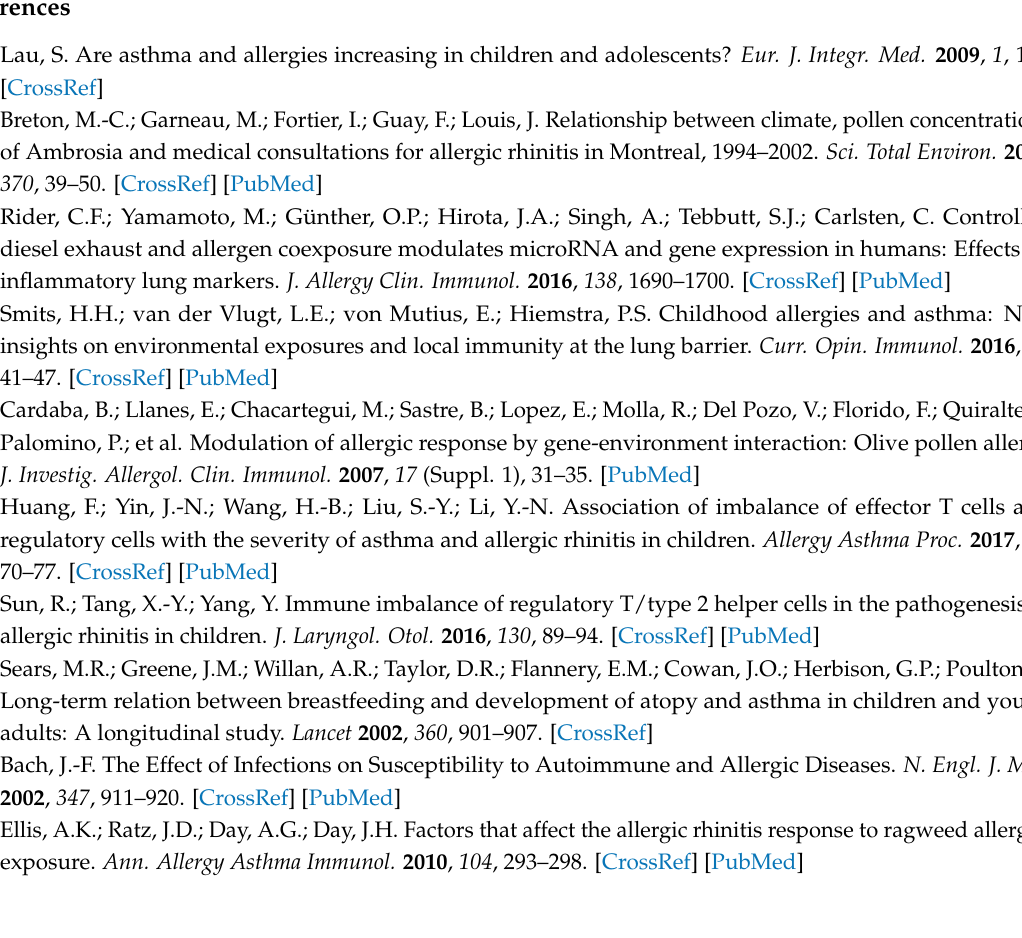
Table S1: Plant-Derived Aeroallergens in the Major Floristic Zones of